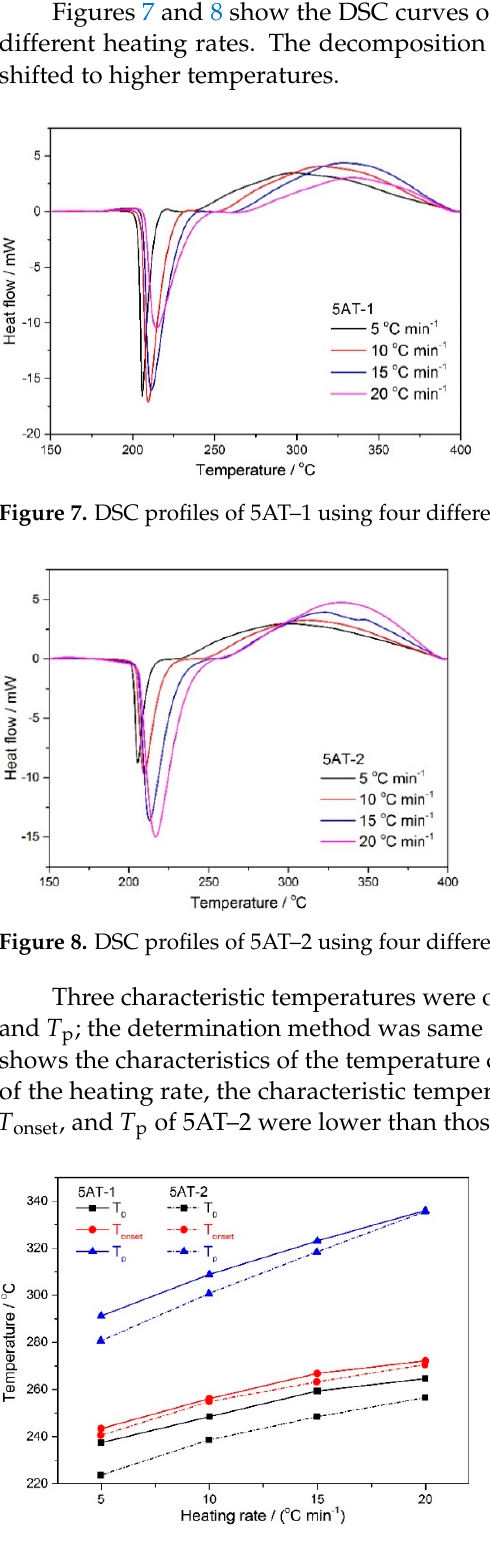
Figure 6. Comparison for E vs. α between 5AT–1 and 5AT–2 obtained using KAS method.